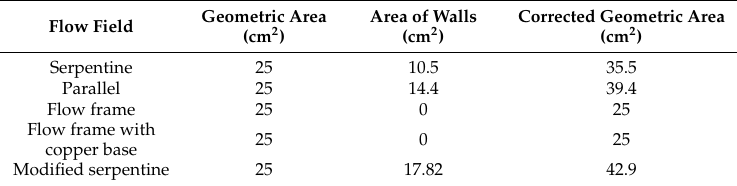
Figure 4. Nyquist plots for the different flow fields at ( a ) 1.3 V and ( b ) 1.0 V, and ( c ) graphs of ohmic and ( d ) charge transfer resistance. Table 2. Active area and corrected geometric active area of each flow field.